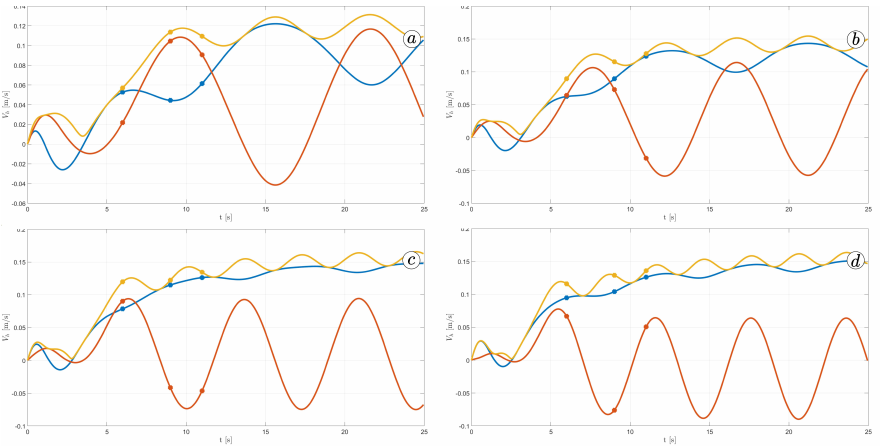
Figure 32. Velocity of the snake robot’s head for ω = 30 ◦ ( a ), ω = 40 ◦ ( b ), ω = 50 ◦ ( c ), and ω = 60 ◦ ( d ).